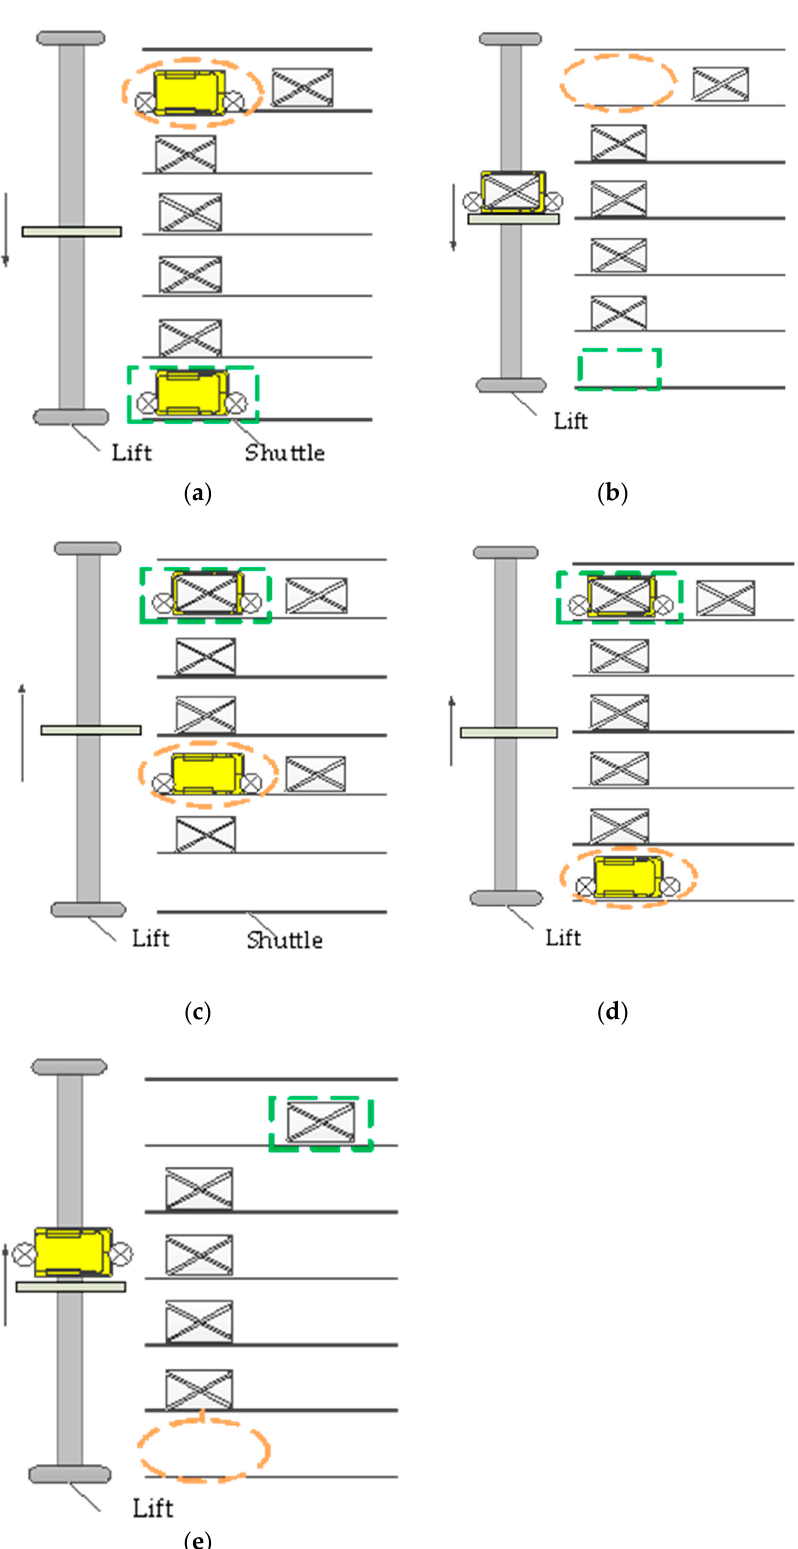
Figure 3. Operation of Lifts. ( a ) The movement of an idle shuttle; ( b ) The movement of a loading shuttle; ( c ) The movement of a lift between two tiers; ( d ) The movement of an idle lift; ( e ) The movement of a loaded lift.